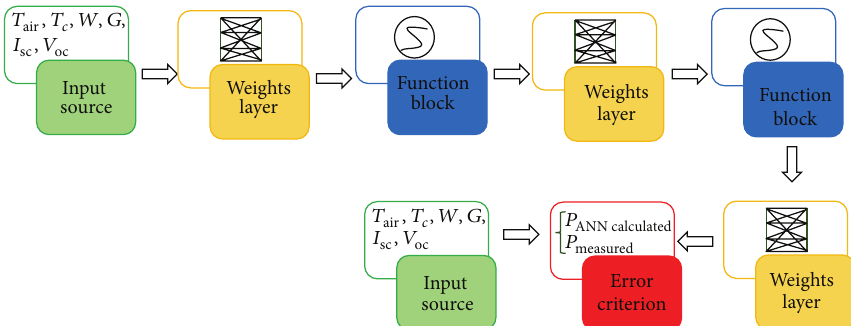
Figure 9: Schema of one hidden layer MLP topology for the power output evaluation.